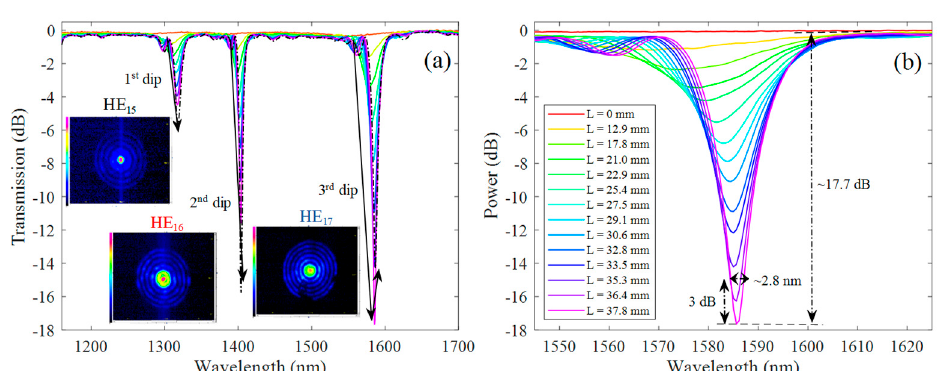
Figure 6. ( a ) LPG transmission spectra over time (i.e., as the grating length increases), obtained using the amplitude mask technique, by scanning a UV laser beam with velocity of 125 µm/s along a 690 µm period amplitude mask. The inset shows the experimental near-field profile of the modes corresponding to the attenuation dips. ( b ) Inset of the 3rd transmission dip (HE 17 mode) as function of the grating length.